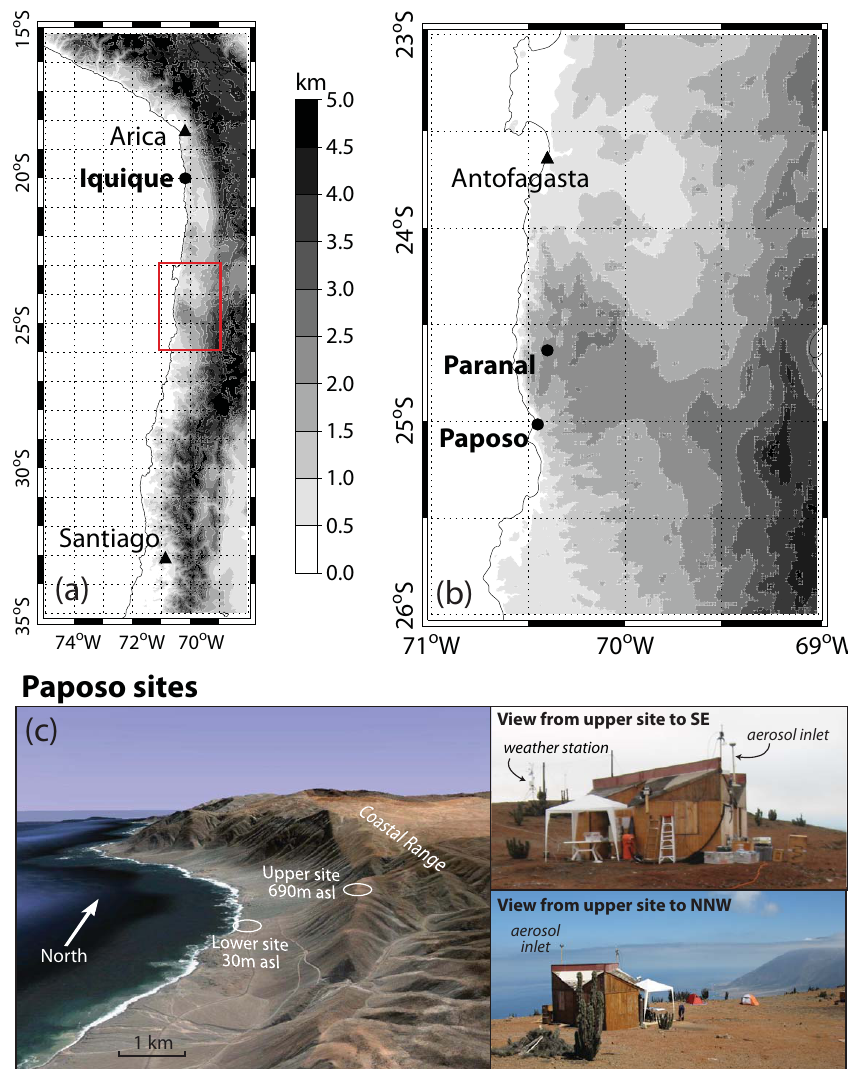
Fig. 4. (a) Map showing location of ground sites used in VOCALS-REx, with (b) a zoomed in map for the red boxed area in (a). Panel (c) shows a Google Earth terrain image showing the Paposo sites looking approximately northward, together with photographs from the upper (elevated) Paposo